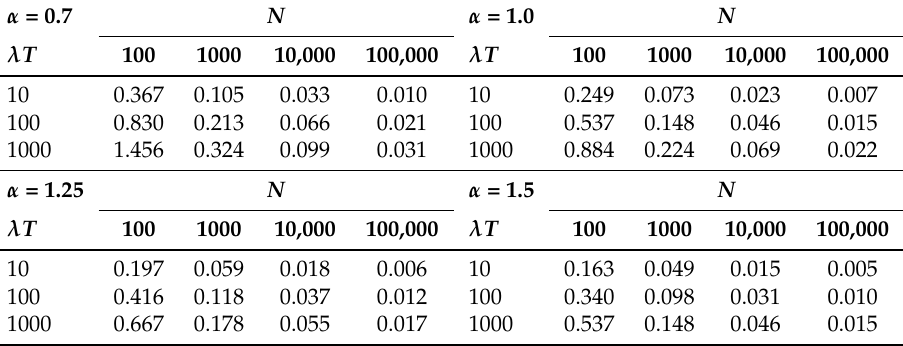
Table 2. Values of COV m (Coefficient of variation of the mass) for various T , α , λ and N . α = 0.7 N α = 1.0